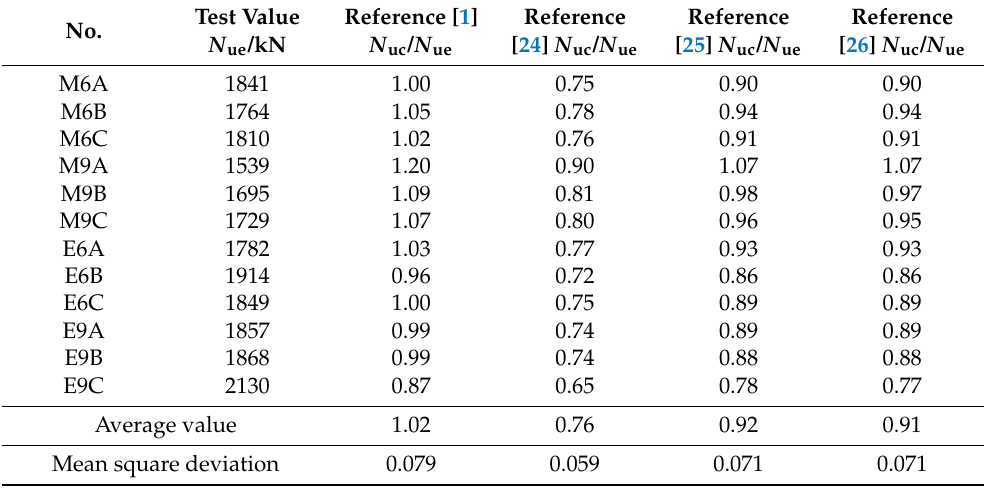
Table 4. Comparison between calculated value and test value of bearing capacity of specimens.